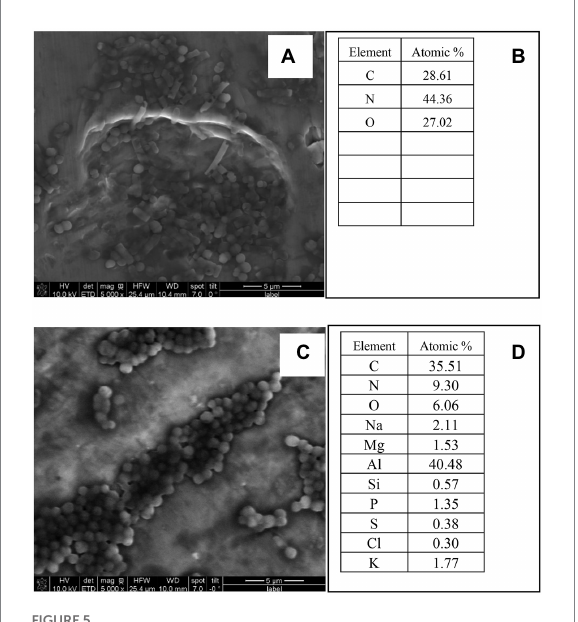
FIGURE 5 SEM-EDS images and elements of E. durans (A,B) and E. faecalis (C,D) and the peaks of the EDS of the main